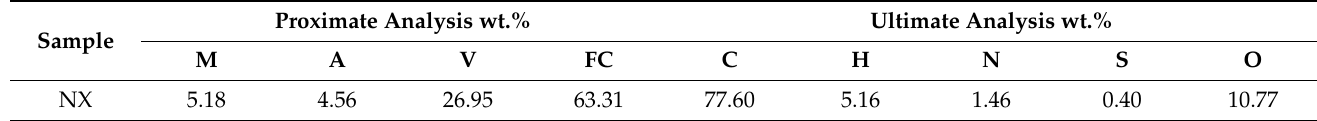
Table 1. The proximate analysis and ultimate analysis of NX coal. Proximate Analysis Sample